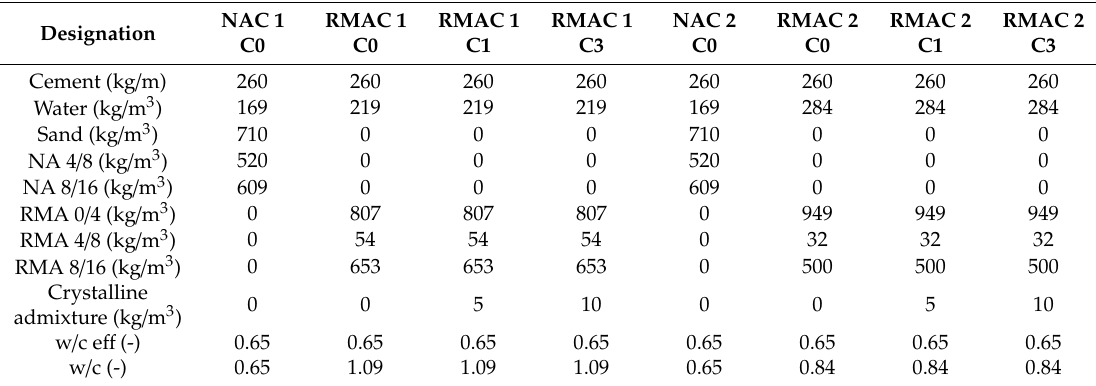
Table 2. Concrete mix proportion, per cubic